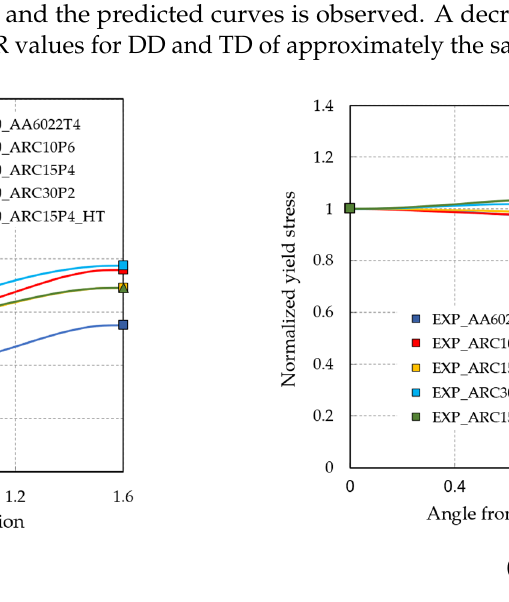
Figure 14. Evolution of R values ( a ) and normalized yield stress ( b ) with rolling. The plane stress yield surfaces of the AA6022 ‐ T4 ‐ T4 sheet are presented in Figure 15. The balanced biaxial yield stress used as input in the Yld2000 ‐ 2d coefficient, assures a great accuracy in reproducibility of the yield surface in the critical region of biaxial stretch ‐ ing. The effect of ARC on the yield surface is observed in DD and TD through the normal ‐ ized values of σ 45 and σ 90 .